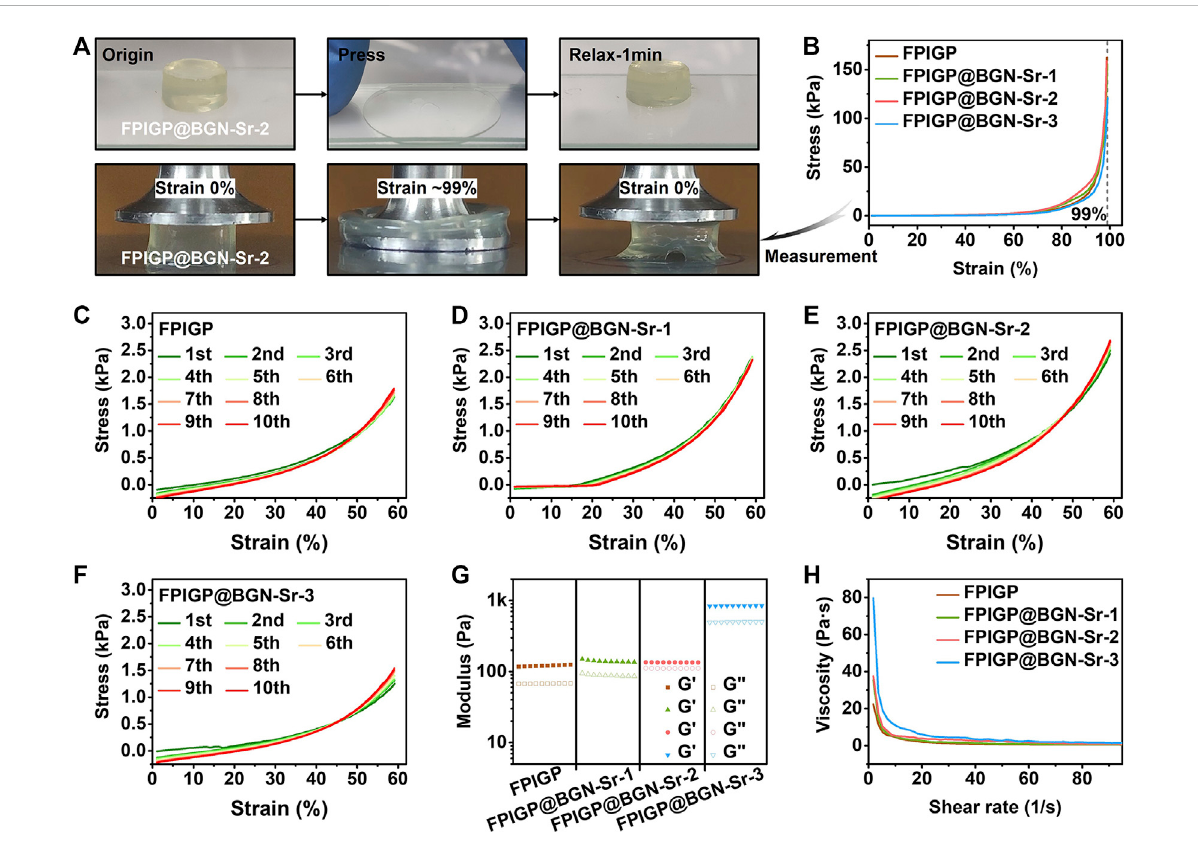
FIGURE 3 Physicochemical properties of hydrogels. (A) The photographs of FPIGP@BGN-Sr-2 hydrogel before and after being squeezed between two glass sheets. (B) The stress ‒ strain curves of FPIGP and FPIGP@BGN-Sr hydrogels. (C – F) The stress ‒ strain curves of (C) FPIGP hydrogel, (D) FPIGP@ BGN-Sr-1hydrogel, (E) FPIGP@BGN-Sr-2hydrogeland (F) FPIGP@BGN-Sr-3hydrogelwithin10cyclesat60%strain. (G) TheG ′ andG ″ ofFPIGPand FPIGP@BGN-Sr hydrogels. (H) The viscosity of FPIGP and FPIGP@BGN-Sr hydrogels with a shear rate from 1 to 100